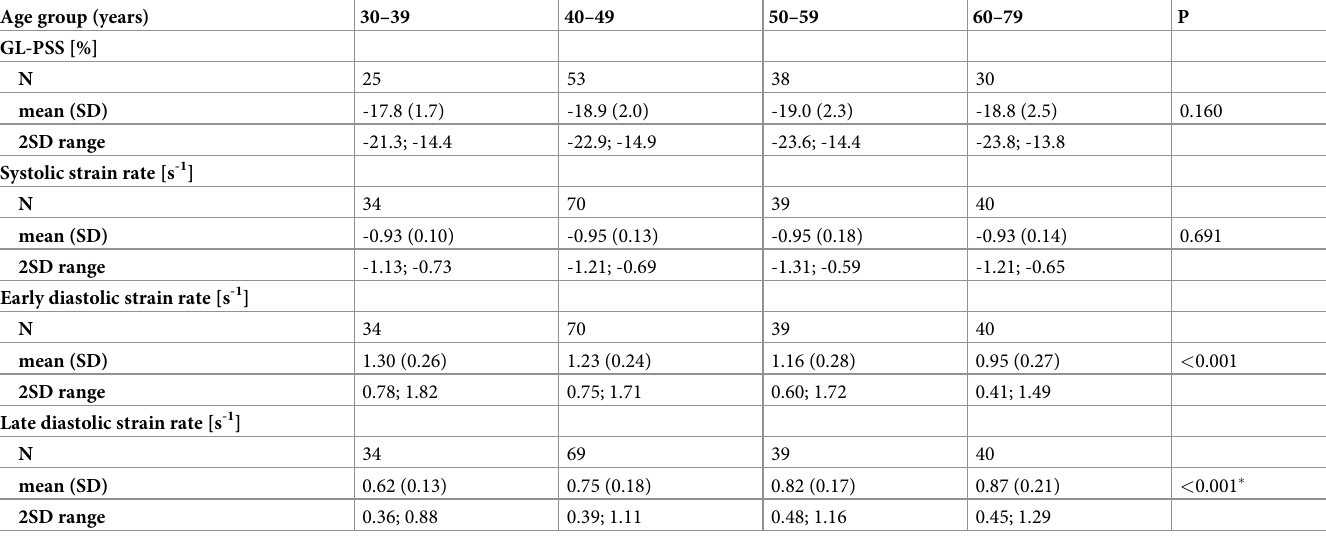
Table 2. Speckle tracking derived markers of left ventricular myocardial deformation in male participants by age group.